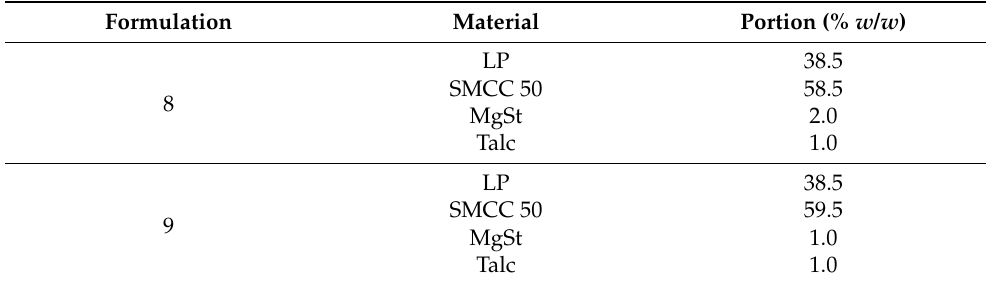
Table 2. Overview of formulations of development step II. LP = losartan potassium; MgSt = magne- sium stearate; SMCC = silicified microcrystalline cellulose.